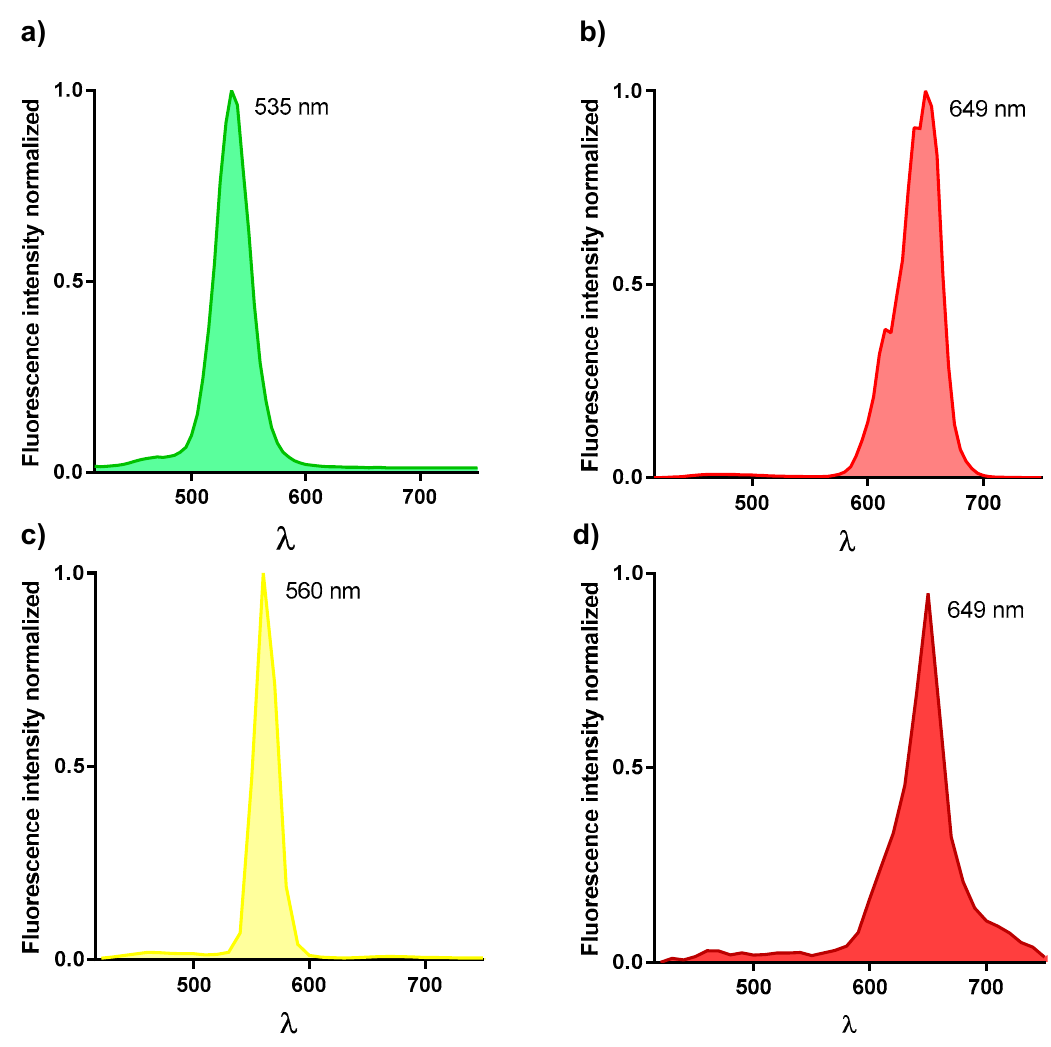
Figure 5. Spectral characterization of QDs. Emission spectrum of QDs was determined with a confocal microscope. Individual signals of QDs emission peaks were recorded. ( a ) QD520 ( b ) QD655 ( c ) QD565-Ab2 and ( d ) QD655-Ab2, and no spectral crosstalk between QD channels was observed.